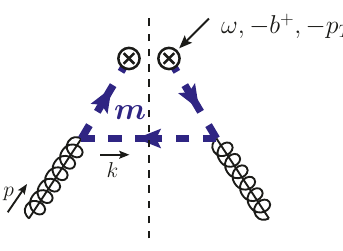
Figure 19 . One-loop diagram contributing to the massive quark beam